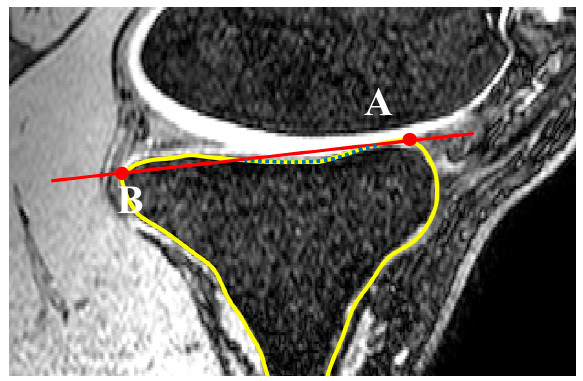
Figure 10. Definition of nodes placed on the concavity in a sagittal slide (dotted line). Nodes A and B